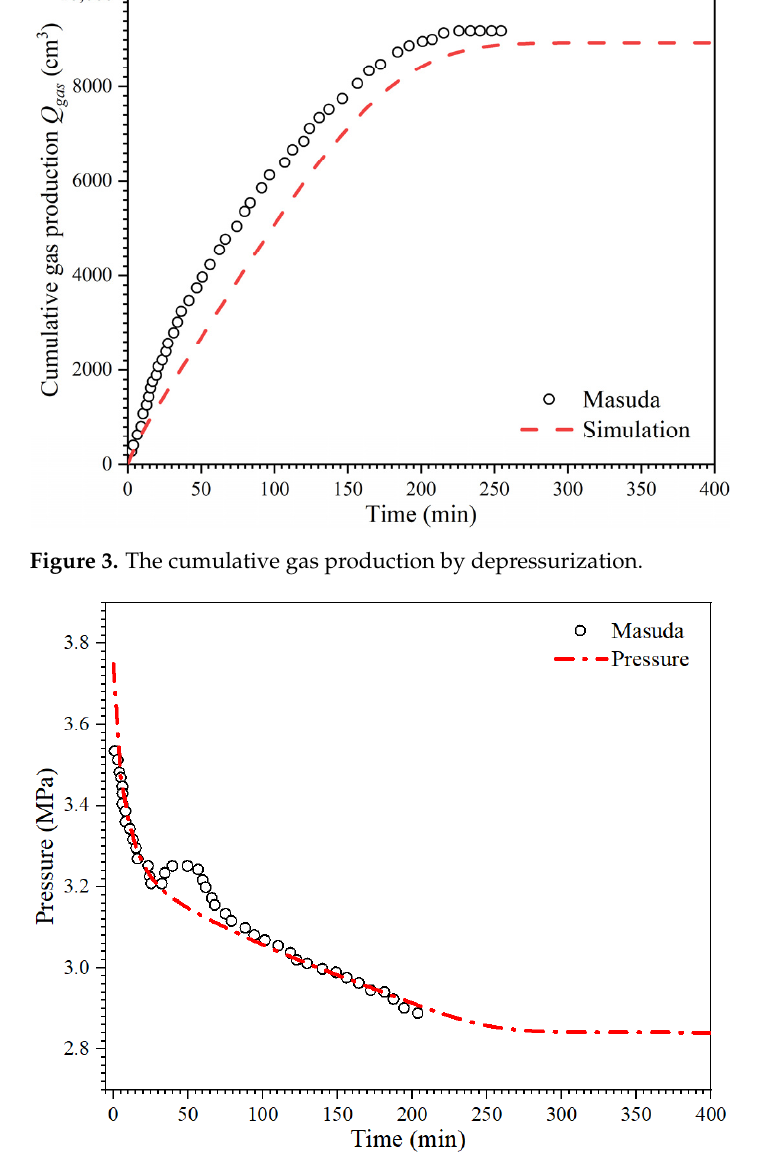
Figure 3. The cumulative gas production by depressurization.